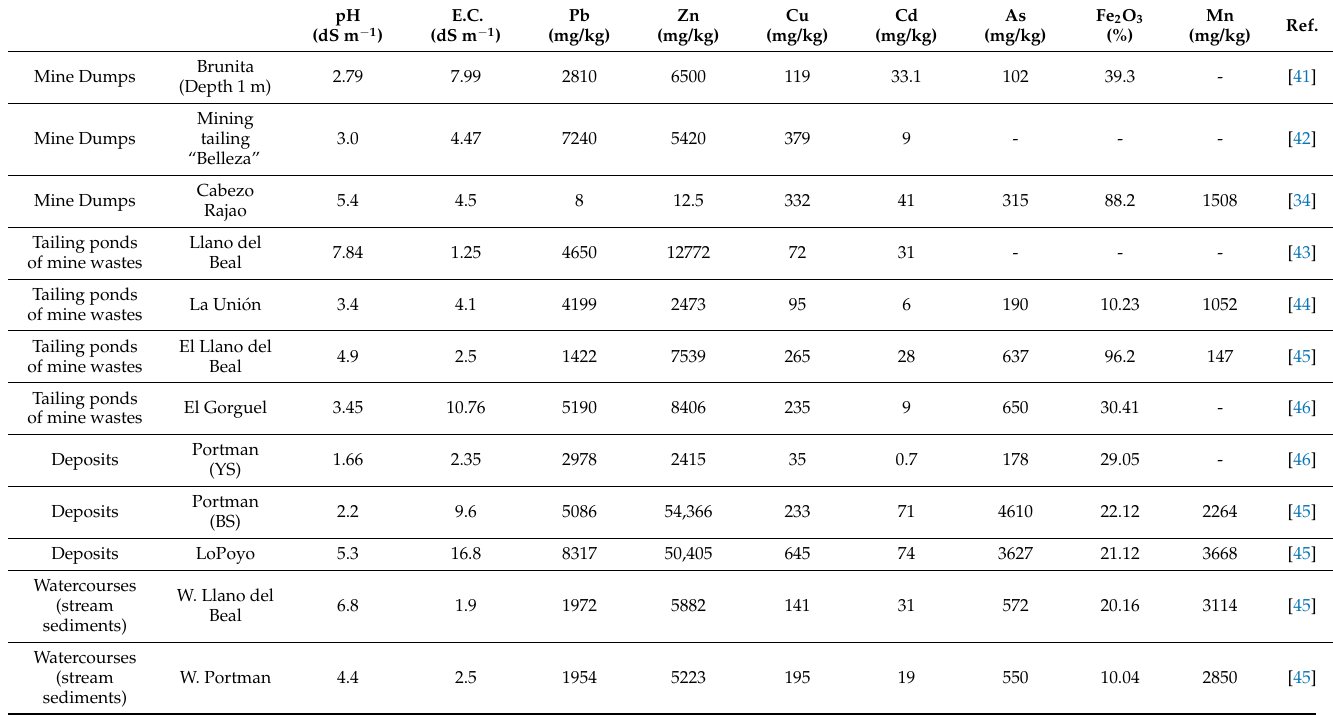
Table 2. Fe 2 O 3 total, PTE content, pH and Electrical Conductivity (EC) values of the abandoned residues in the study area (median